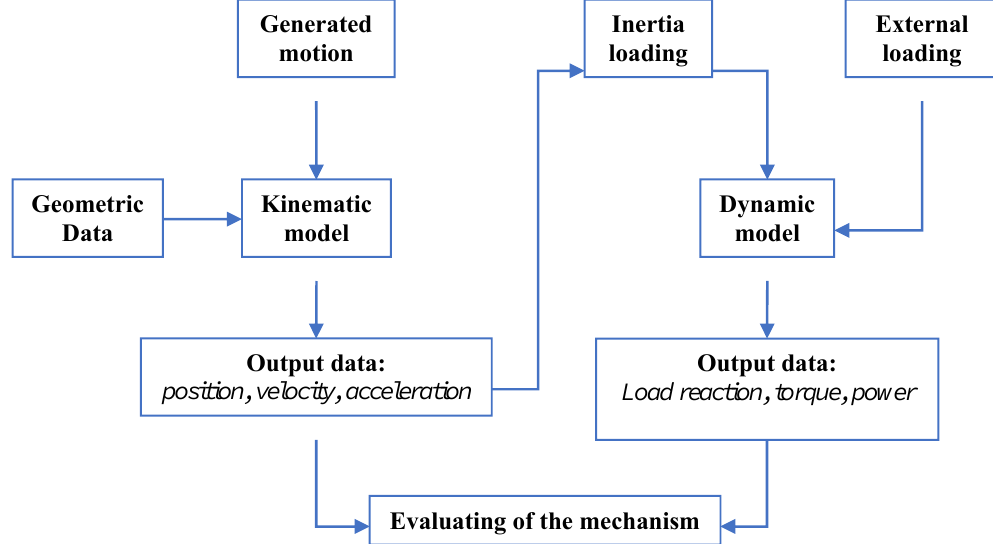
Figure 1. General Bloc diagram to evaluate a mechanism based on a multibody simulation.